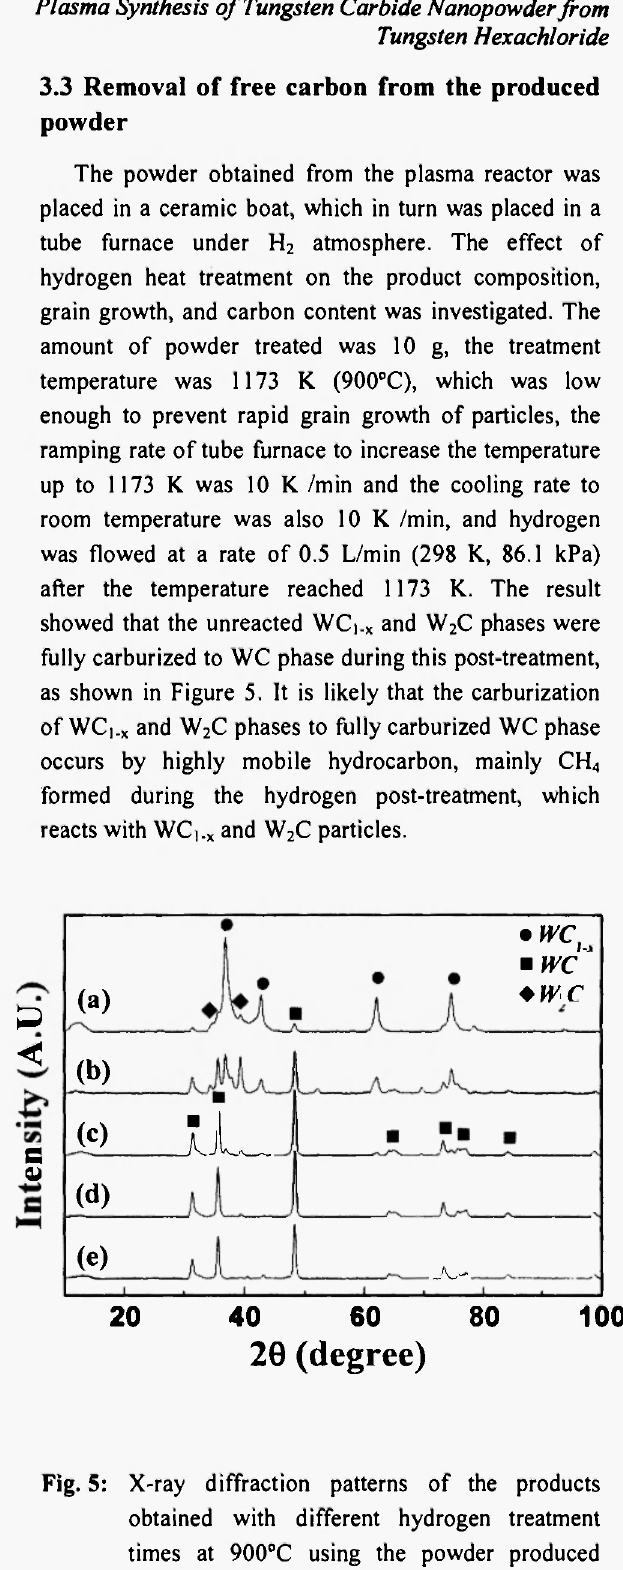
Fig. 5: X-ray diffraction patterns of the products obtained with different hydrogen treatment times at 900°C using the powder produced from the plasma reactor: (a) before treatment, (b) l hour, (c) 2 hours, (d) 3 hours, and (e) 5